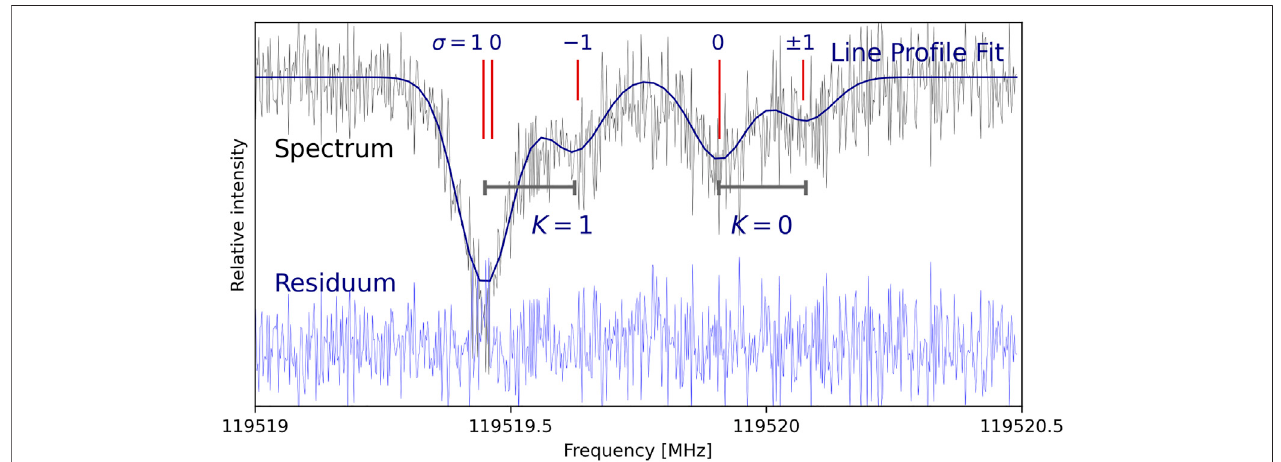
FIGURE2| Zoomintothetransition3 K ← 2 K ( K (cid:2) 0,1)highlightinginternalrotationsplittinginCH 3 NH 3 + .FourGaussianfeatureshavebeenassumedinperforming alinepro fi le fi t.Theredverticalbarsshowthelocationofthe fi vepossible σ torsionalcomponentslabeledatthetopwiththelengthofthebarsindicatingtheircontribution from spin statistical effects, see text for details. The gray horizontal markers indicate the torsional splitting of some 170 kHz observed in this particular transition (cf. transition frequencies collected in Table 1 , Model II).